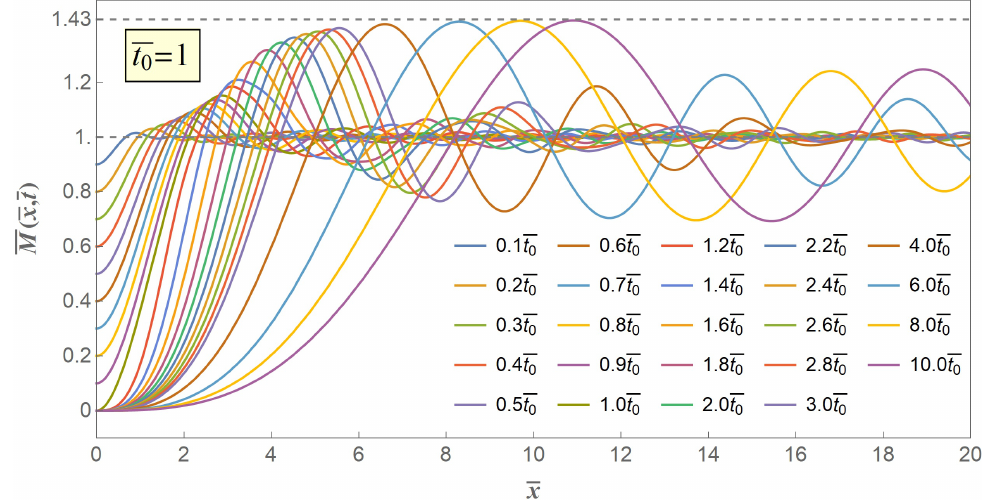
Figure 4. Schematic of excited bending moment versus distance when t 0 =